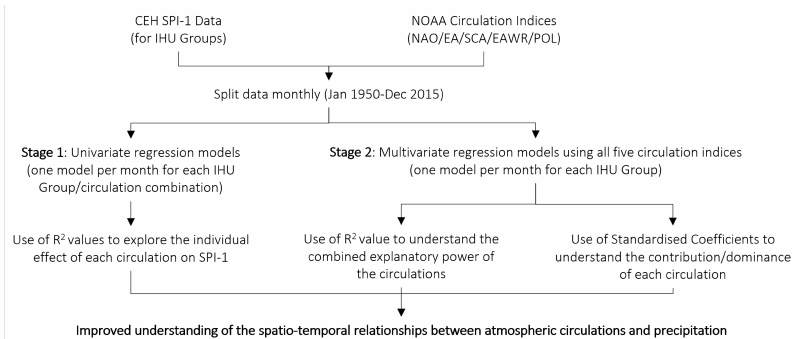
Figure 1. Flow chart summarizing the methodological stages of this